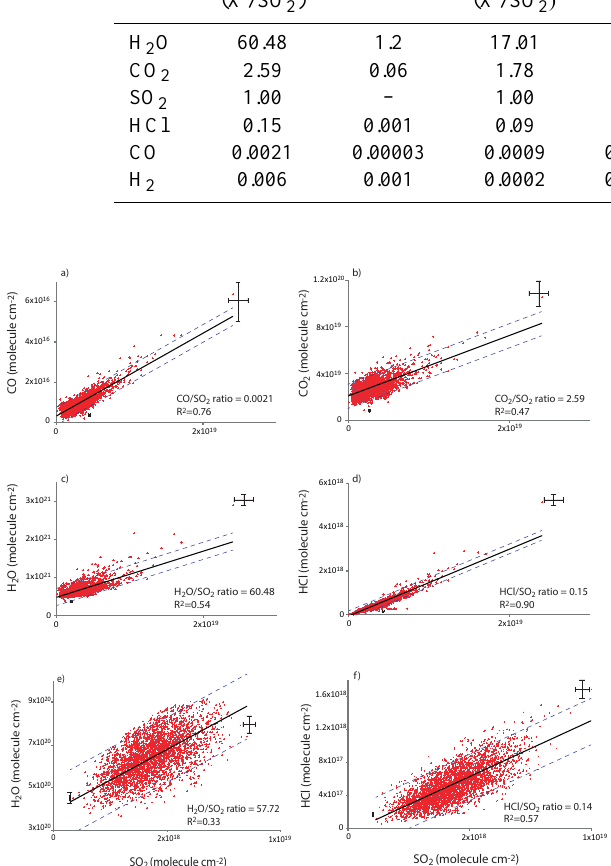
Figure 5. Scatter plots showing column amounts of each volcanic gas species vs. SO 2 . The upper four scatter plots show data acquired on 26 March 2013 sampling of the Turrialba mixed plume, directly south of the 2010 vent using an IR lamp as source and a 35m path length. (a) CO, (b) CO 2 , (c) H 2 O and (d) HCl. The lower three scat- ter plots show data acquired on 25 March 2013 sampling the 2012 vent using incandescence from the vent as the IR source and a 350m path length. (e ) H 2 O and (f) HCl. The y -axis offsets seen in (b) , (e) , (c) and (g) represent the atmospheric background column amounts of CO 2 and H 2 O respectively. Dashed lines show prediction bands at 95% confidence